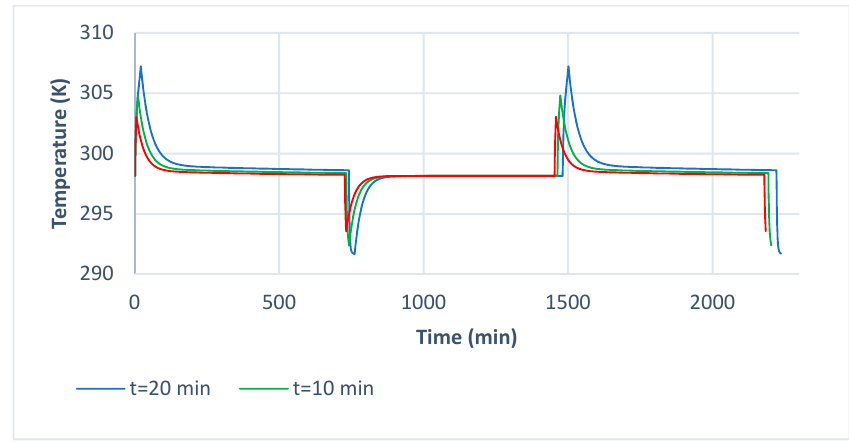
Figure 17. Gas temperature trend for the Second Configuration varying the charging time.